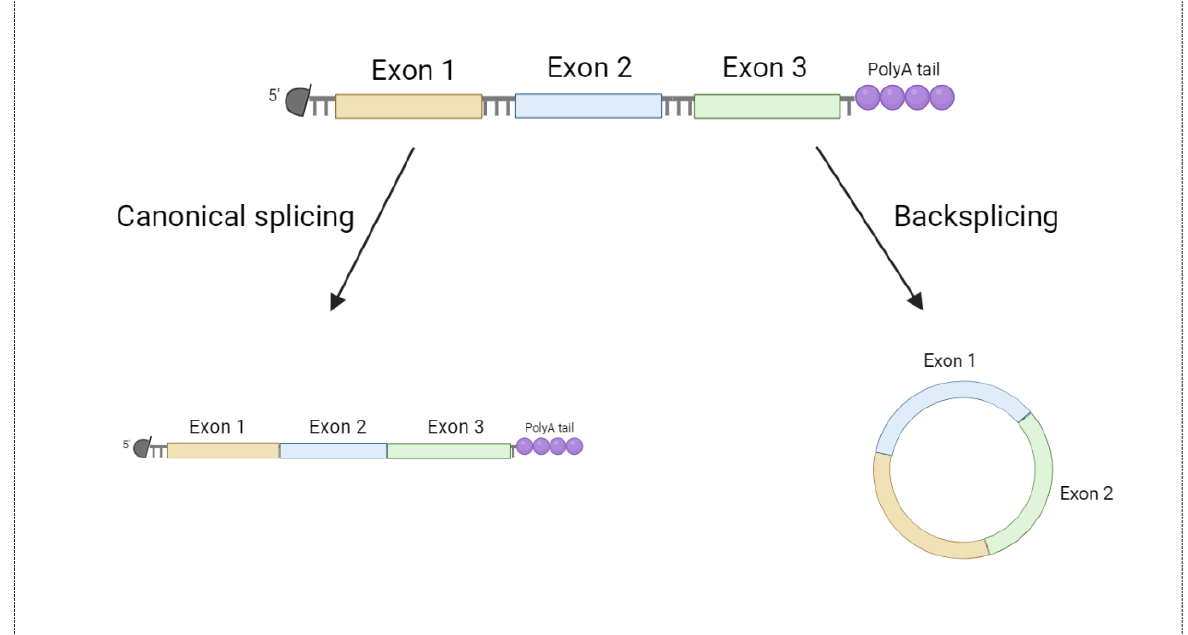
Figure 5. Circular mRNA generation via backsplicing. Modified from [59]. Figure was created using BioRender tool.